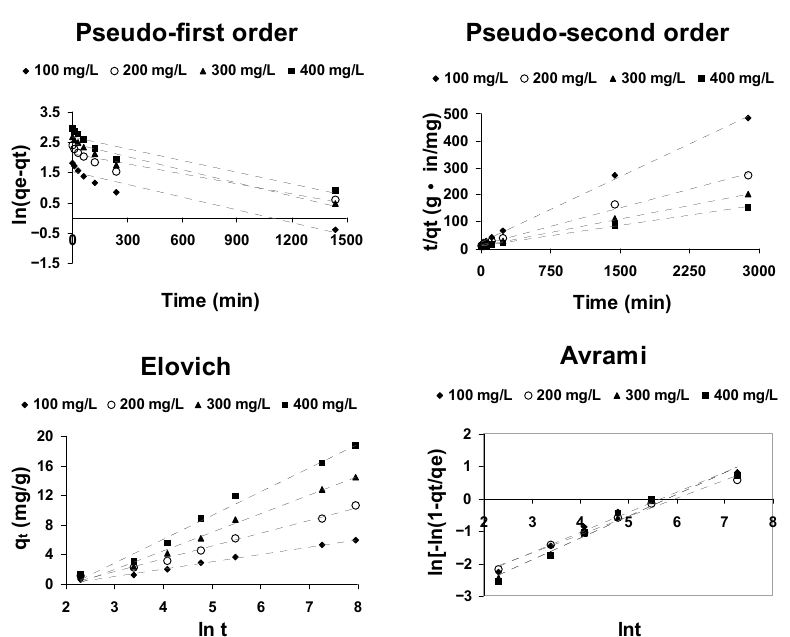
Figure 7. Kinetic plots for the adsorption of CPC onto AOS at 20°C.